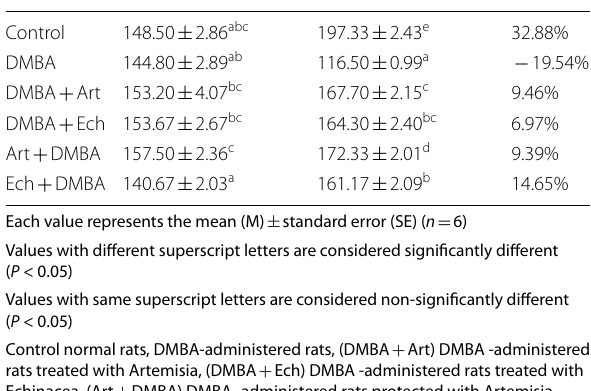
Table 2 Effect of treatment or protection with Artemisia or Echinacea on hemoglobin content (HB), red blood corpuscles (RBCs), white blood cells (WBCs) and platelets count in DMBA‑administered rats of all experimental groups